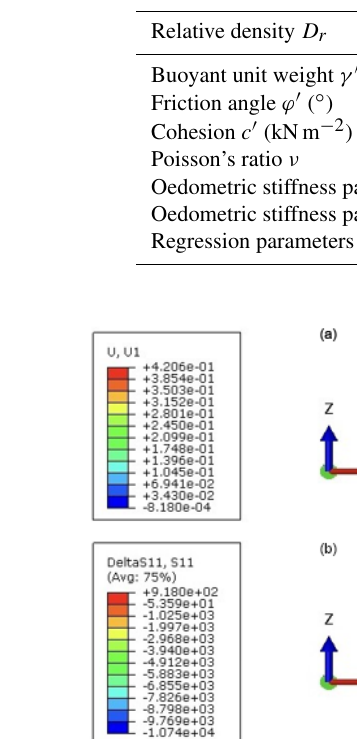
Table 1. Material parameters used for sand with three different relative densities.